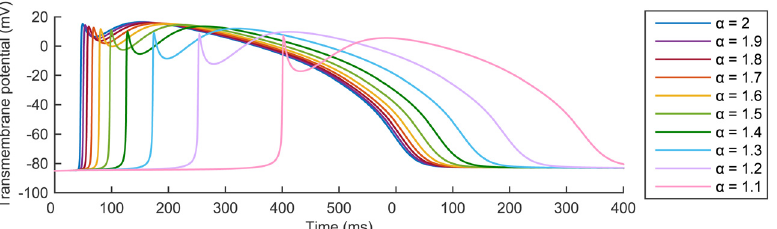
Fig 4. Temporal profile for t 2 [0,500 ms] of the solution obtained with ten different values of α at the mid-point of the spatial domain [0, 1 cm]. In all cases the stimulus I stim = 40 μ A (cid:3) cm − 3 was applied on [0,0.05 cm] at t stim = 10 ms for two consecutive milliseconds and then